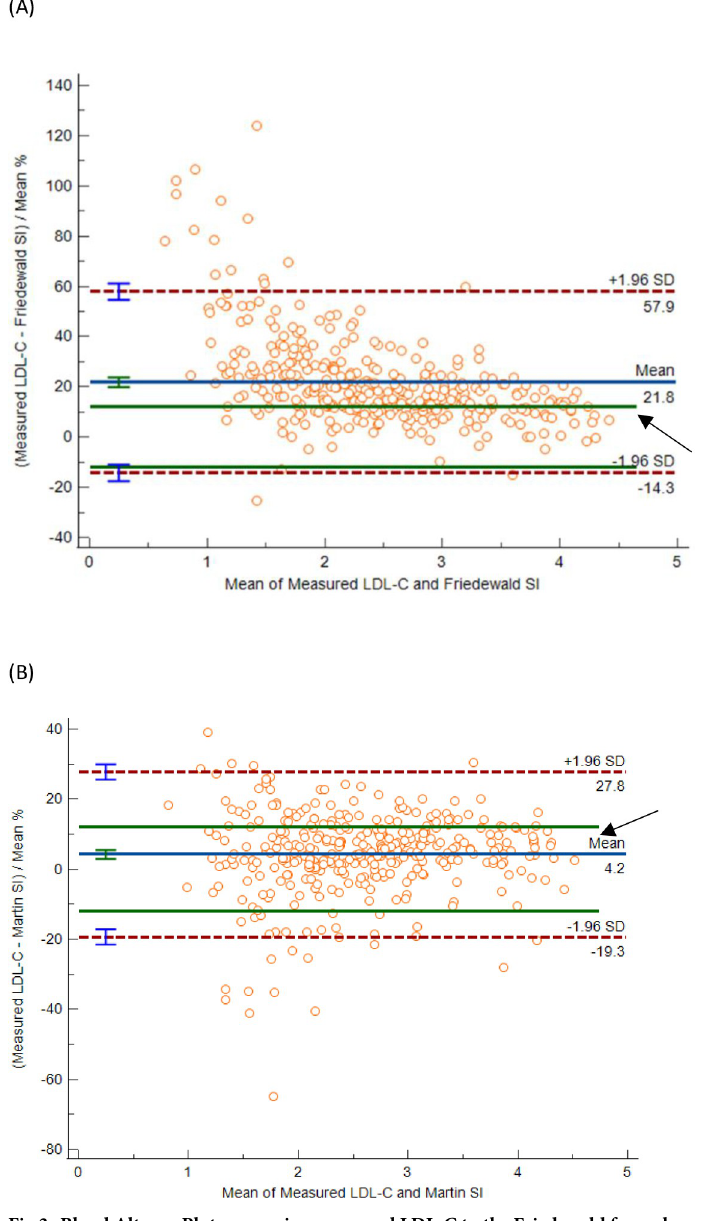
Fig 3. Bland Altman Plot comparing measured LDL-C to the Friedewald formula and Martin Hopkins formula at TG-C of � 1.7 mmol/L. (A) There is a positive mean bias of 21.8% (95% confidence interval 19.9–23) between measured LDL-C and Friedewald formula. and a reduced positive bias of 4.2% (95% CI 3.0–5.5) with the (B) Martin- Hopkins formula. The total allowable limit of 12% is indicated by the arrow.